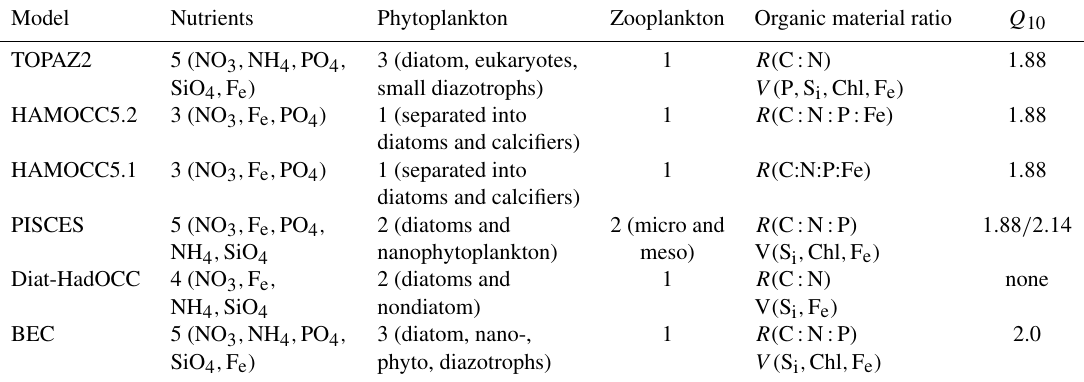
Table 2. A brief description of the marine biogeochemical components included in the ESMs. Nutrients limiting phytoplankton growth, the number of explicit phytoplankton groups, the number of explicit zooplankton groups, representation of heterotrophic bacteria, the use of fixed (Redfield: R ) or variable ( V ) ratios for organic matter production, and Q 10 for temperature dependency of biogeochemical processes (autotrophic/heterotrophic) are